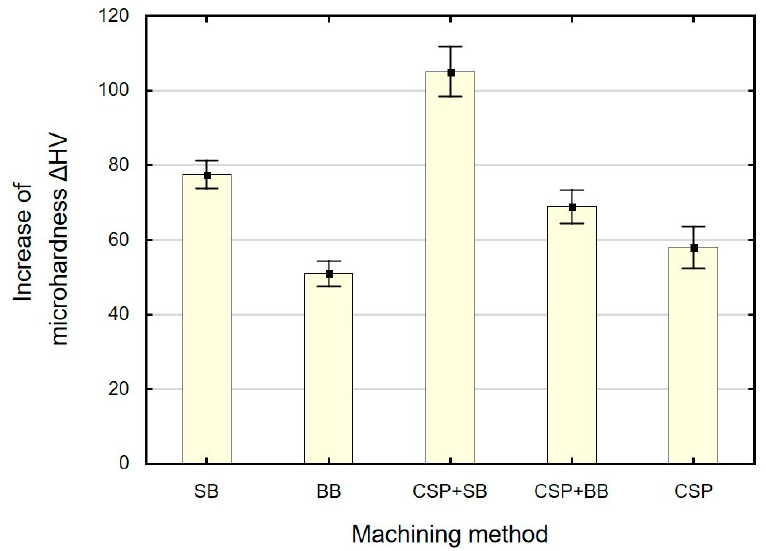
Figure 11. Finishing method versus increase in microhardness ∆ HV (SB—slide burnishing, BB—ball burnishing, CSP + SB—centrifugal shot peening + slide burnishing, CSP + BB—centrifugal shot peening + ball burnishing, CSP– centrifugal shot